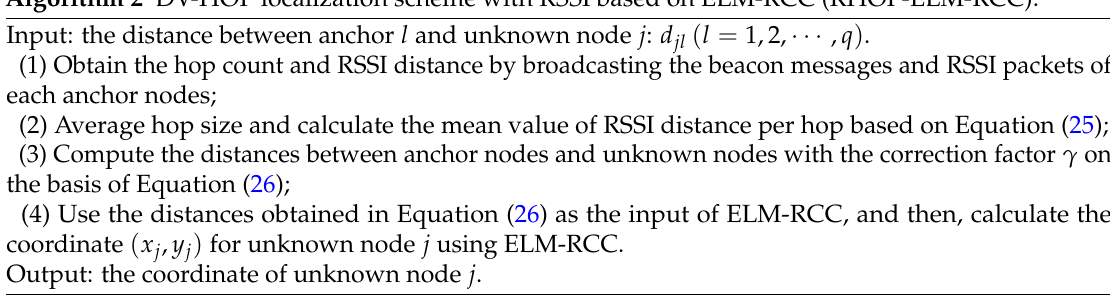
Algorithm 2 DV-HOP localization scheme with RSSI based on ELM-RCC